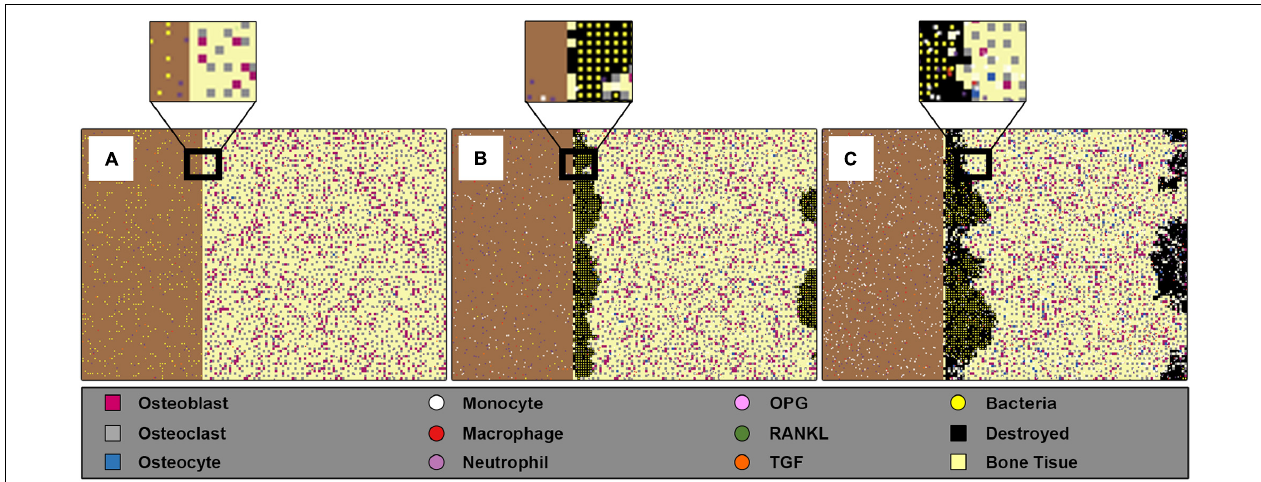
FIGURE 1 | Screenshots of the ABM space at three different time steps for inoculum infection state of (5 × 10 2 CFU/mm 2 ). The left rectangle in each sub-figure represents the bacteria population, and the right rectangle represents 2 mm 2 of bone tissue where the bone cells, osteoblasts, osteoclasts, and osteocytes, are randomly allocated respecting their percentage and minimum distance. (A) Shows the initial state of the model at = 0 h, where the bacteria are randomly distributed in the adjacent surface, the left rectangle, with low presence of immune cells especially macrophages. (B) Shows the state at time t = 60 h, where the bacteria entered the bone tissue and started destroying it. (C) Shows the model’ state at t = 150 h, where the damage happens to the bone tissue, the black patches within bone tissue reflect this destruction, while at the same time the bacteria count was decreased because of engulfing by immune cells.